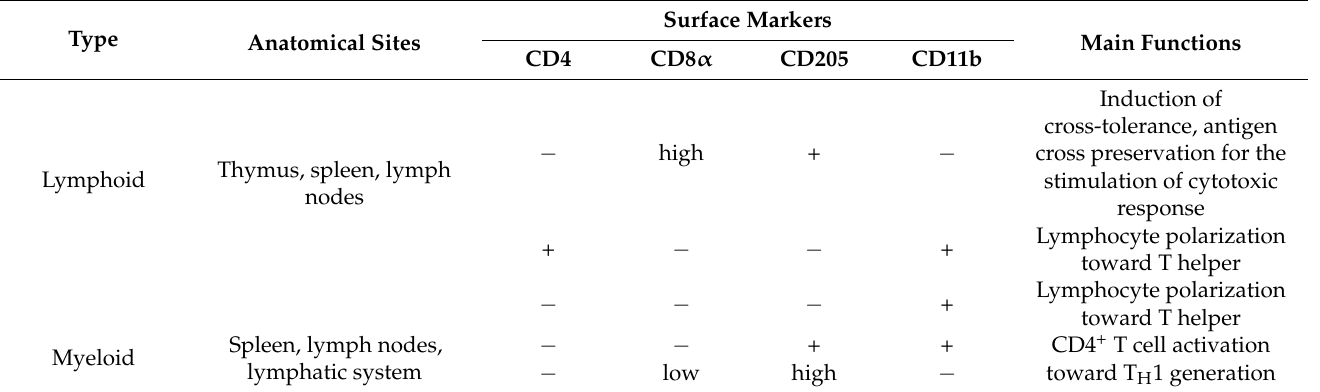
Table 1. Classification of CD11c + MHCII + dendritic